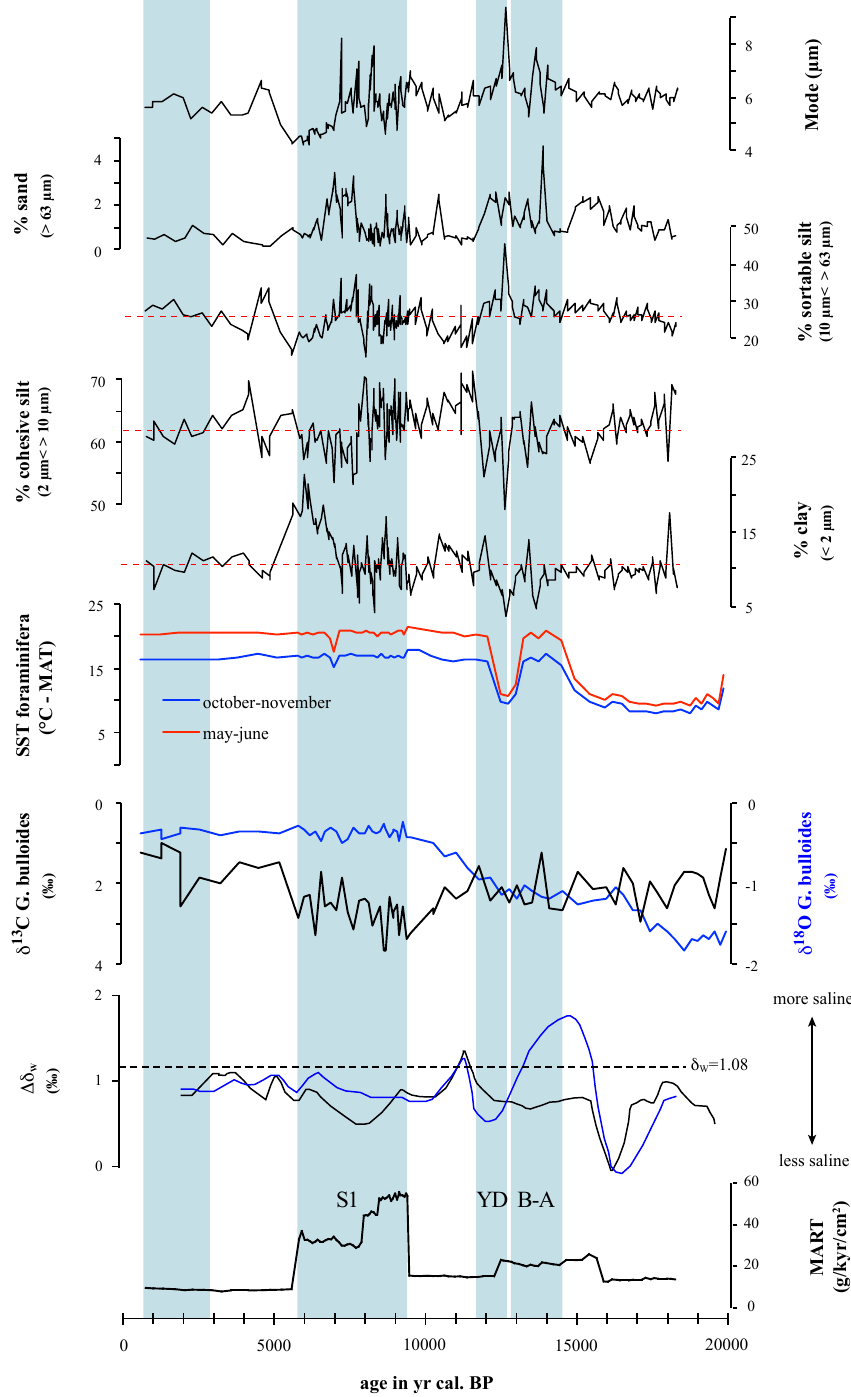
Fig. 3. Grain size analysis of core MD04-2797: main mode (µm), % of sand ( > 63µm), % of sortable silt (10 <> 63µm), % of cohesive silt (2 <> 10µm) and % of clay ( < 2µm). MART (gkyr − 1 cm − 2 ) from Fig. 2. Sea surface temperatures (SST) for May–June and October– November based on foraminifera association (Essallami et al., 2007), δ 18 O (‰) and δ 13 C from planktonic foraminifera G. bulloides (Essal- lami et al., 2007). 1δ W (‰) values are calculated using SSTs derived from MAT (blue) and alkenones (black) (Essallami et al., 2007). Mean analytical uncertainty is ±